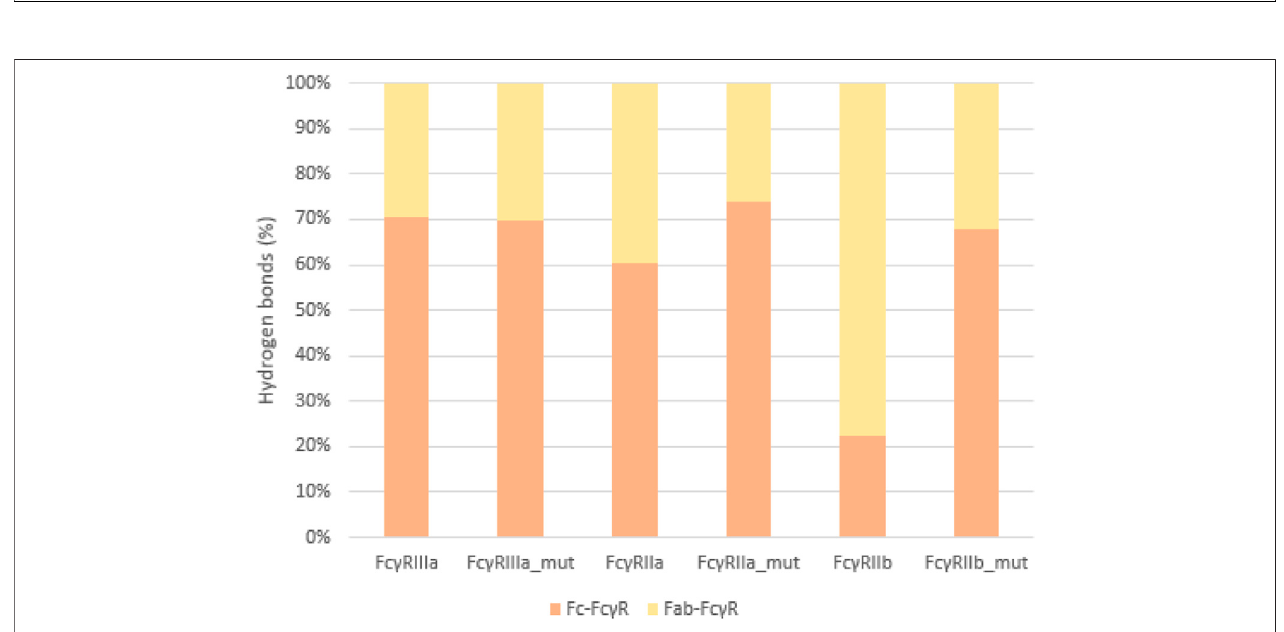
FIGURE 9 | Hydrogen bonds as percentage of all interactions. Comparison between Fc-Fc γ R (orange) and Fab-Fc γ R (yellow) interactions shows that hydrogen bonds formed between Fab region and Fc γ R represent at least 30% of the interactions, indicating their relevance.